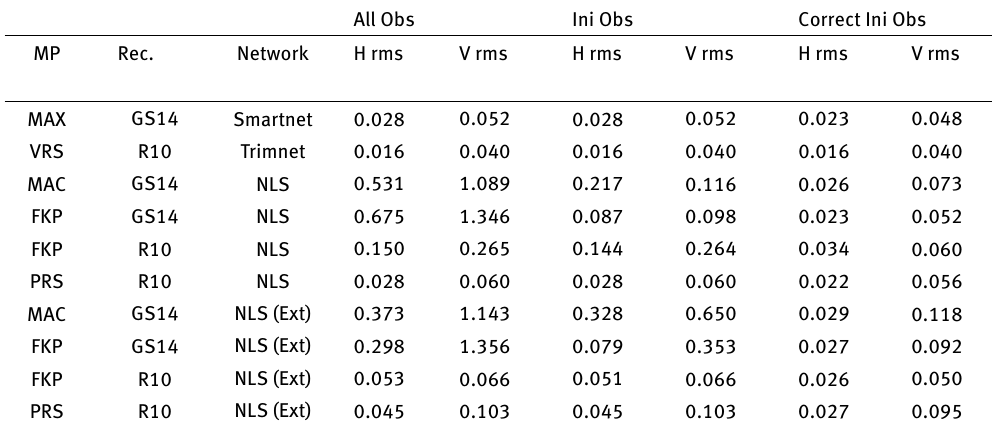
Table 3: Horizontal and vertical rms’s of test configurations in the different initialization categories. All units are in meters. All Obs Ini Obs Correct Ini Obs MP Rec.